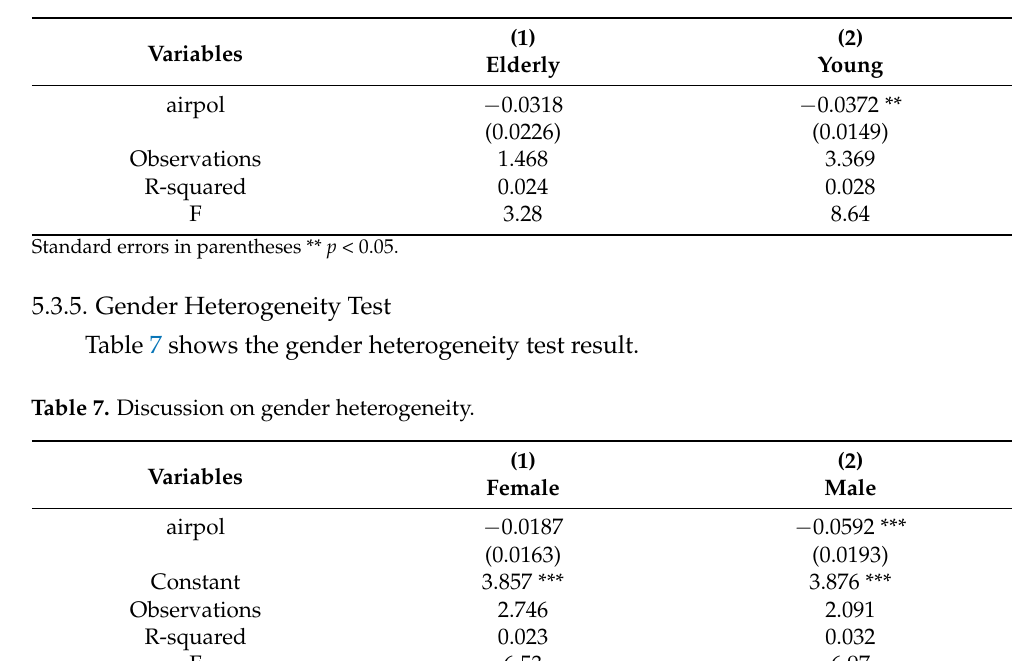
Table 6. Discussion on age heterogeneity.